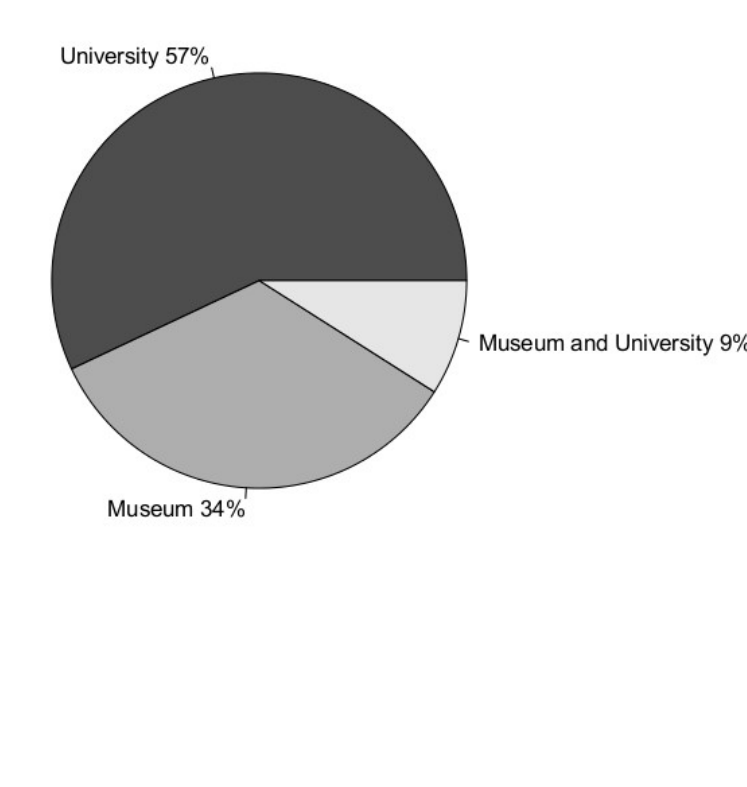
Figure 1. Institution/s in England where survey respondents are based (survey